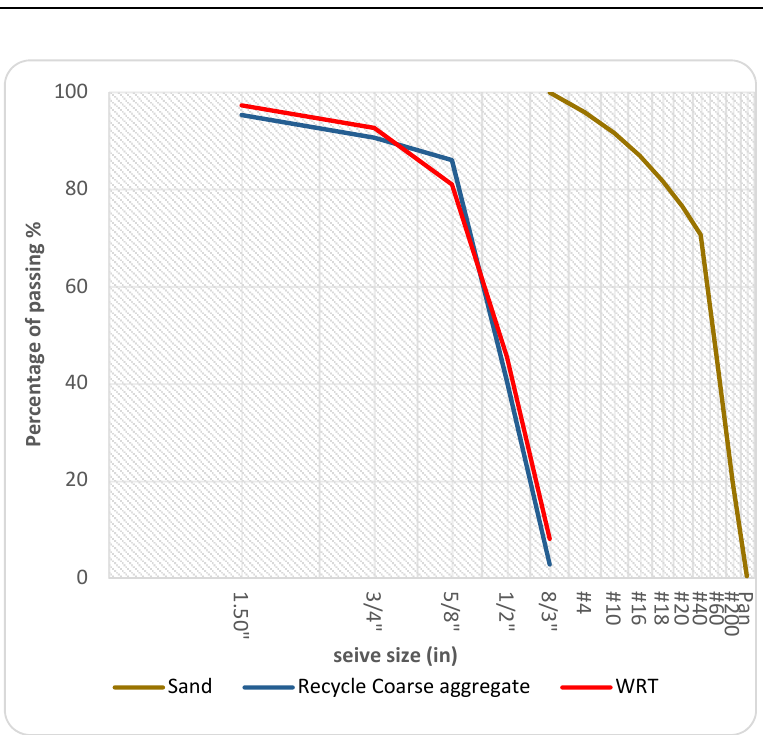
Figure 2. Sieve analysis curves for sand, RCA, and WRT.